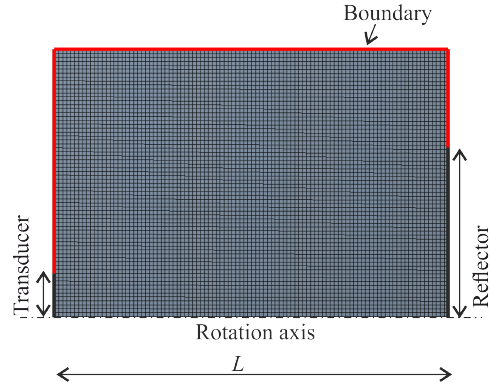
Figure 2. Two-dimensional finite-element-model of the standing wave system.